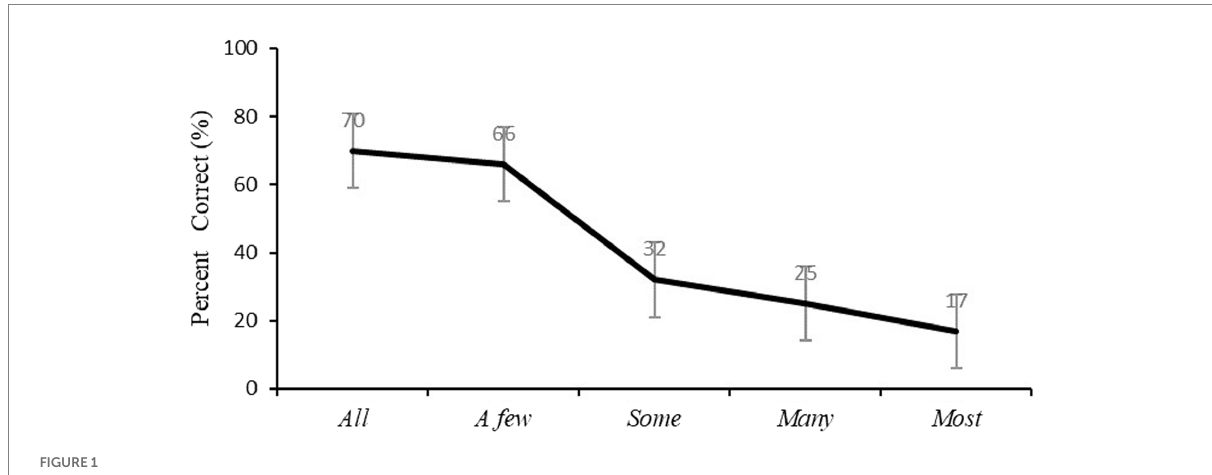
FIGURE 1 Children’s average percent correct for each quantifier.